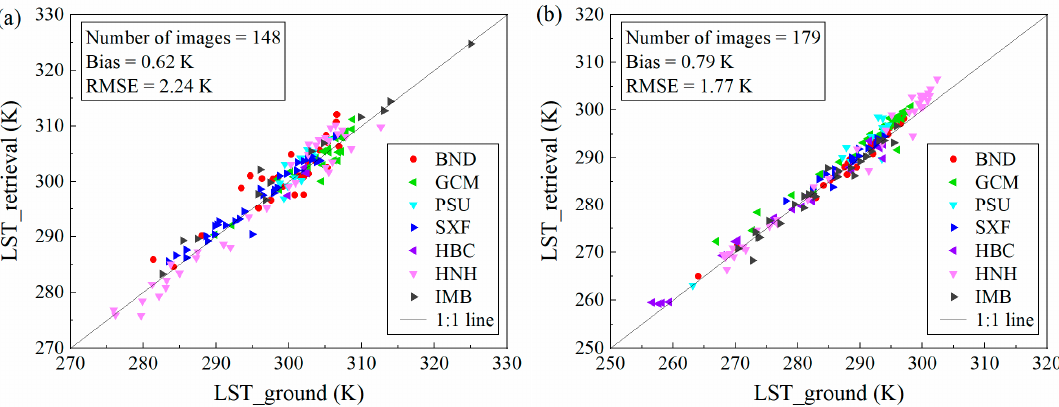
Figure 9. Ground validation in different sites for ( a ) daytime algorithm and ( b ) nighttime algorithm.